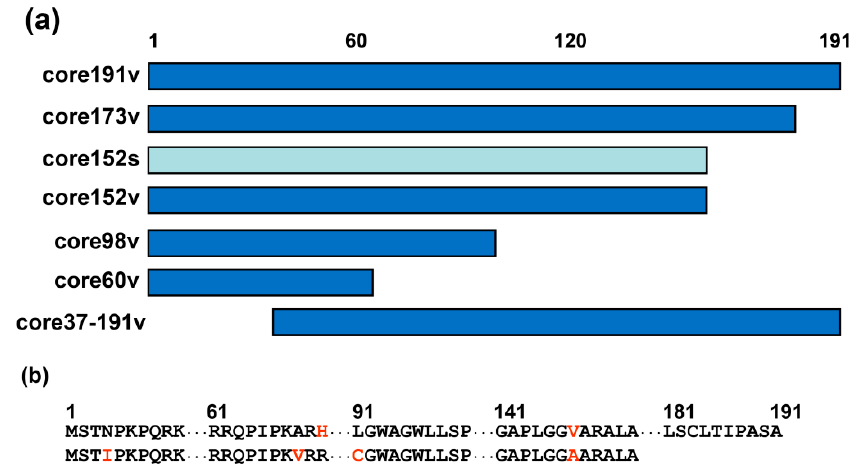
Figure 1. HCV core variants enrolled into DNA immunization. ( a ) Schematic representation of truncated proteins based on HCV core encoded by HCV genotype 1b strain 274933RU [71] (viral, v; in dark blue) or the synthetic DNA [58] (s, in light blue). Abbreviated names of the respective genes are given to the right. ( b ) Amino acid sequences of HCV core genotype 1b, strain 274933RU [68] (upper raw), and HCV core aa 1–152 encoded by the synthetic gene [58] (lower raw). Alignment of core191v and core152s showing the first and the last amino acid residues and regions of amino acid differences (in red).